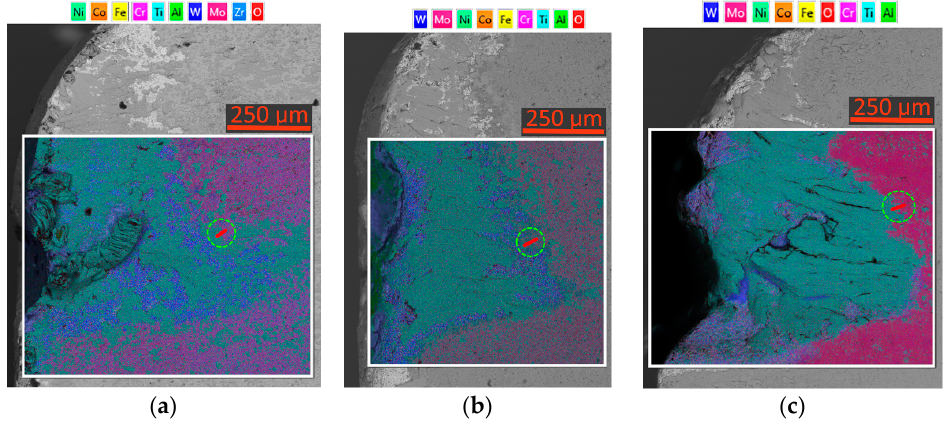
Figure 3. General view of the worn-out rake face of the tool; distribution map of the main elements and localization of the areas for cutting out the lamellas for further studies. Coatings: ( a ) M1, ( b ) M2, ( c ) M3.